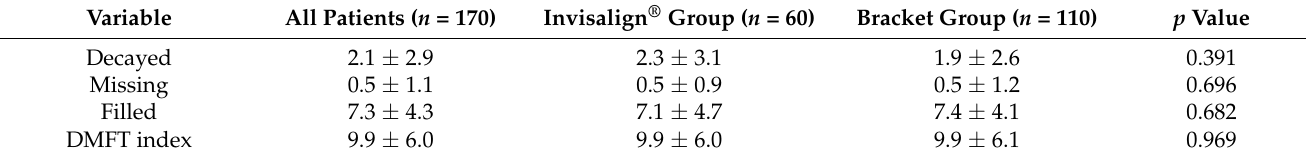
Table 6. Decayed, missing, and filled tooth (DMFT) index of patients, stratified by orthodontic device (Invisalign ® or bracket) ( n = 170).